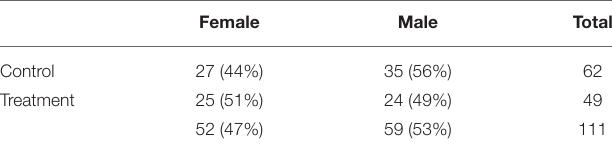
TABLE 1 | Number of individuals by group and gender. TABLE 2 | Overview of social skills measured by different economic